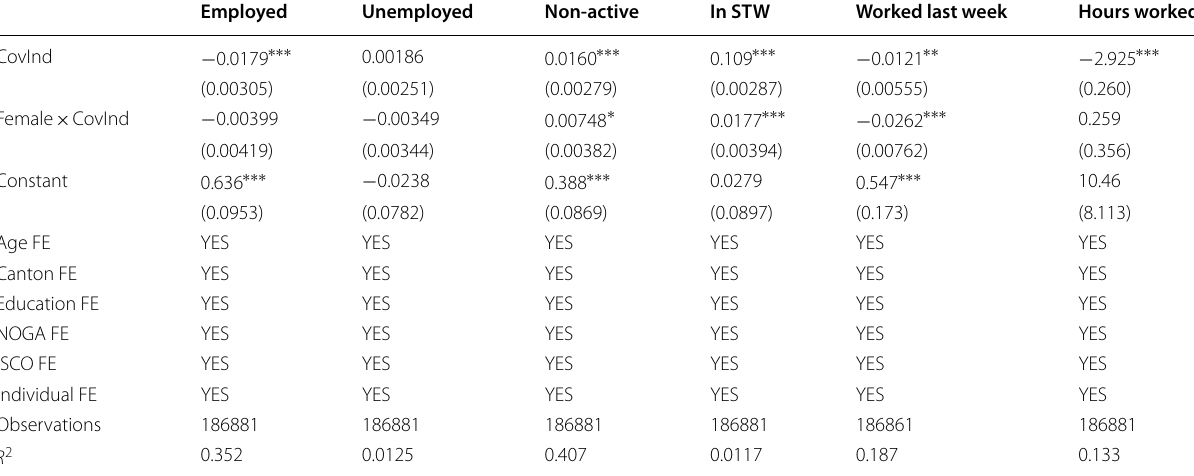
Estimates from regression (1) of labor market status, being in STW, worked last week and hours on a constant, COVID-19 index, and its interaction with the female dummy. Regressions estimated with linear probability model, including individual fixed effects. Robust standard errors in